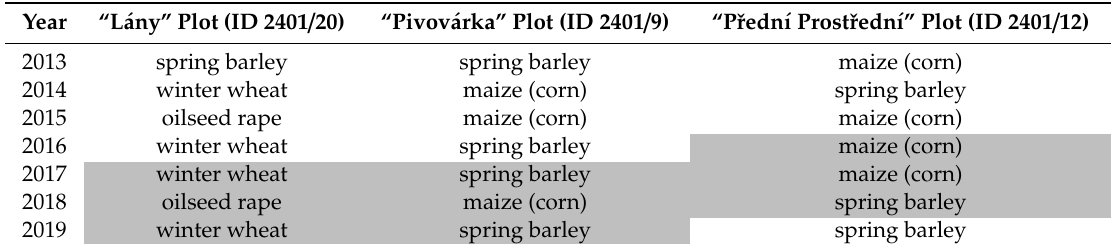
Table 1. Information on crops from 2013 to 2019 for the area of study for which the yield productivity zones were computed. The years in which the yield measurements from the field harvesters were available are highlighted with a grey